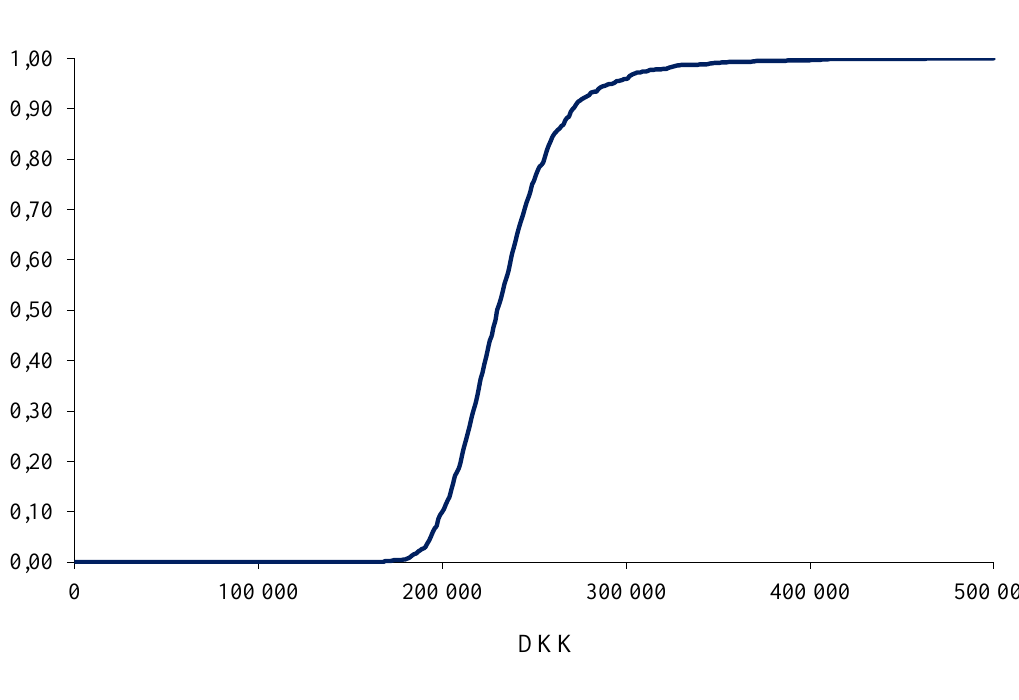
Figure 4: Cost-effectiveness acceptability